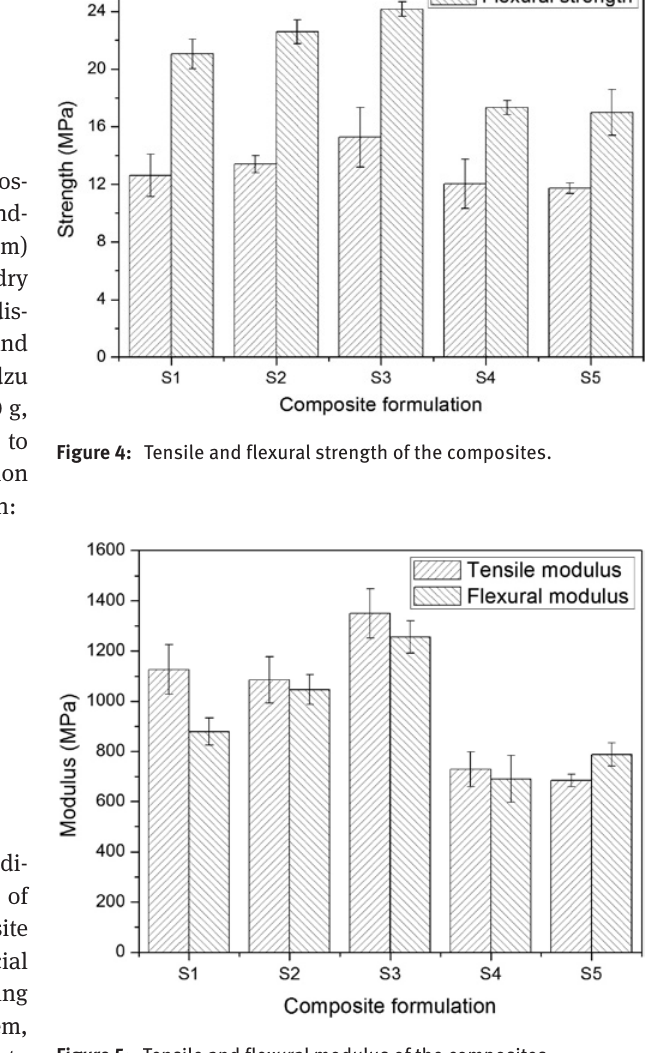
Figure 5: Tensile and flexural modulus of the composites.